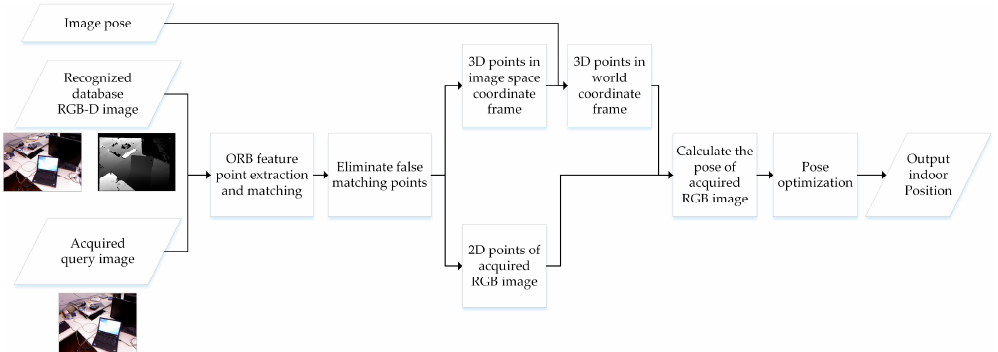
Figure 6. Process of the pose estimation.